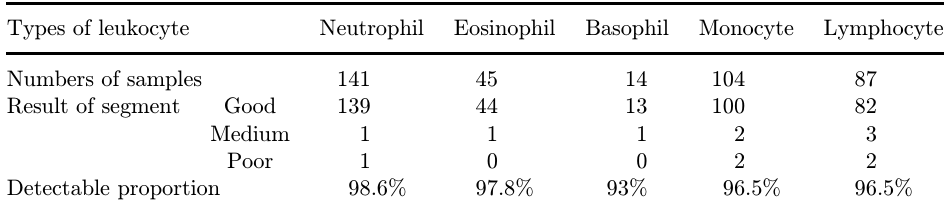
Table 2. Segmentation results of ¯ve types of